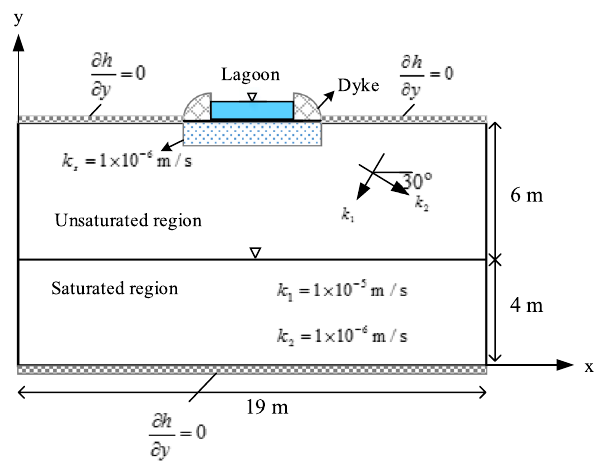
Fig. 21 Computational domain and boundary conditions for the fifth problem